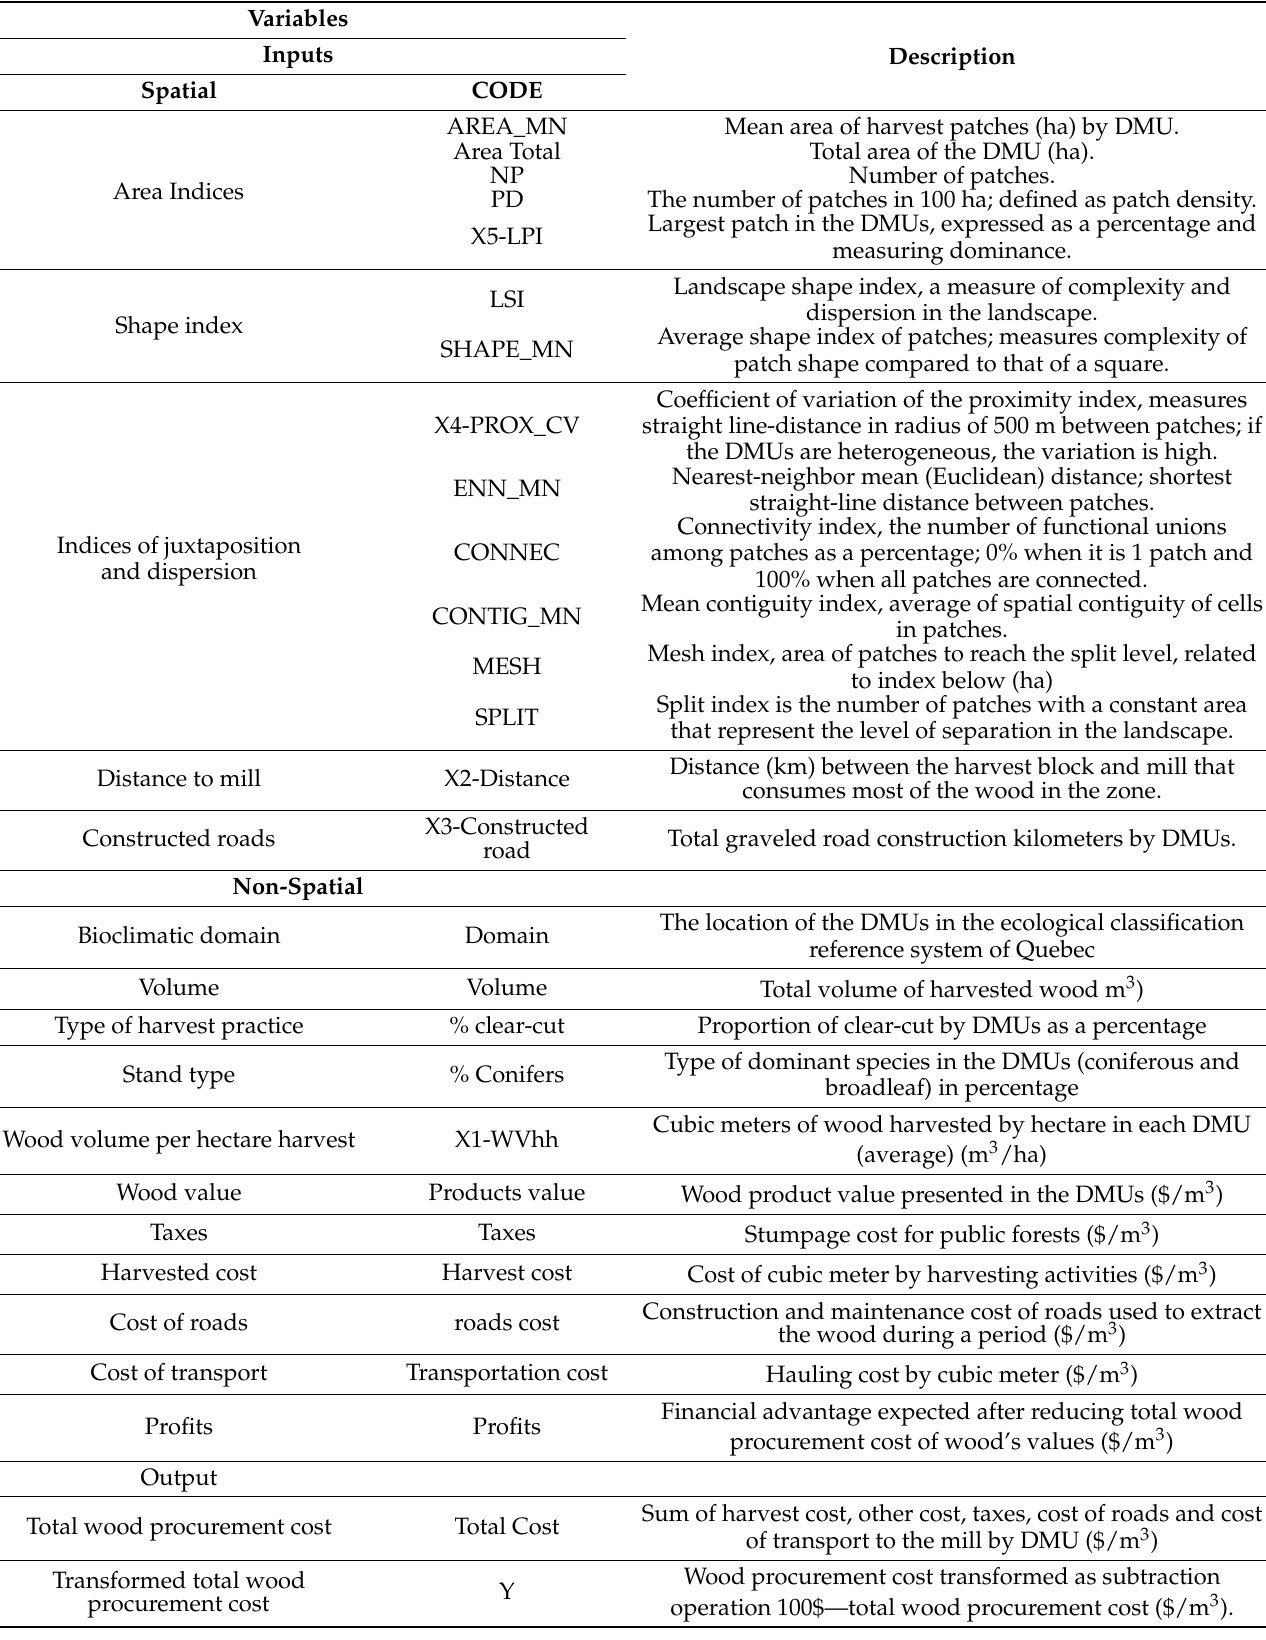
Table 1. Description of the spatial and non-spatial variables for the study area. Variables with codes prefixed by an X or Y are the ones used in the DEA